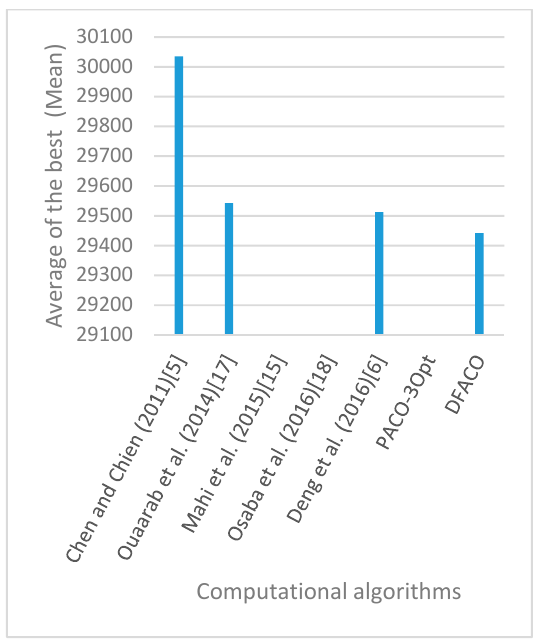
Figure 23. Average of best solutions obtained for instance kroB200 by all algorithms.